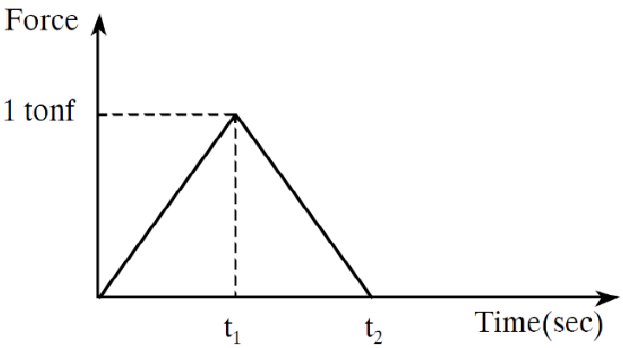
Figure 5. Time histogram function concept.